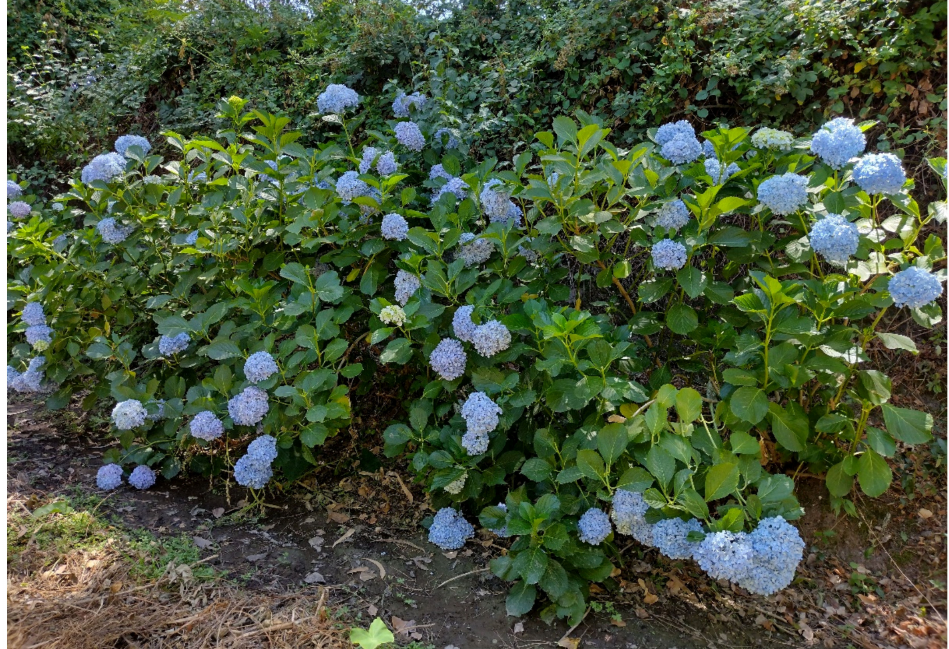
Figure 48. Hydrangea macrophylla along Acqua Mariana channel (Acquedotti